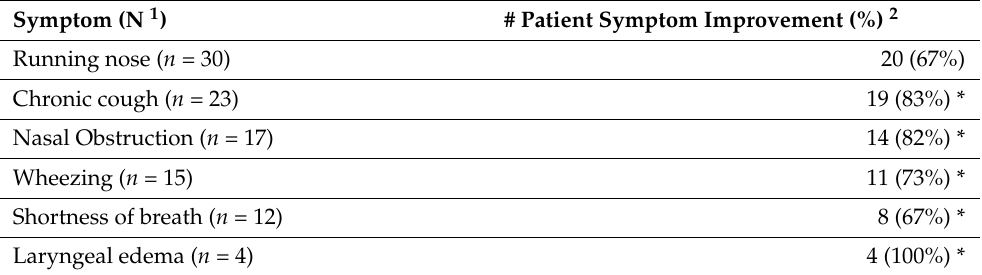
Table 4. Distribution of respiratory symptoms in infants ≤ months of age with diagnosed or sus- pected CMPA.